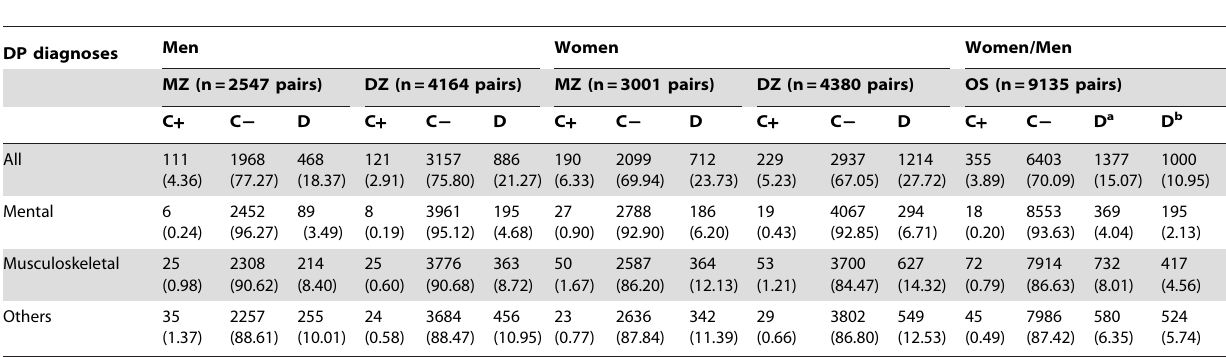
Table 2. Numbers (%) of concordant and discordant twin pairs in different disability pension (DP) diagnostic groups, by sex and